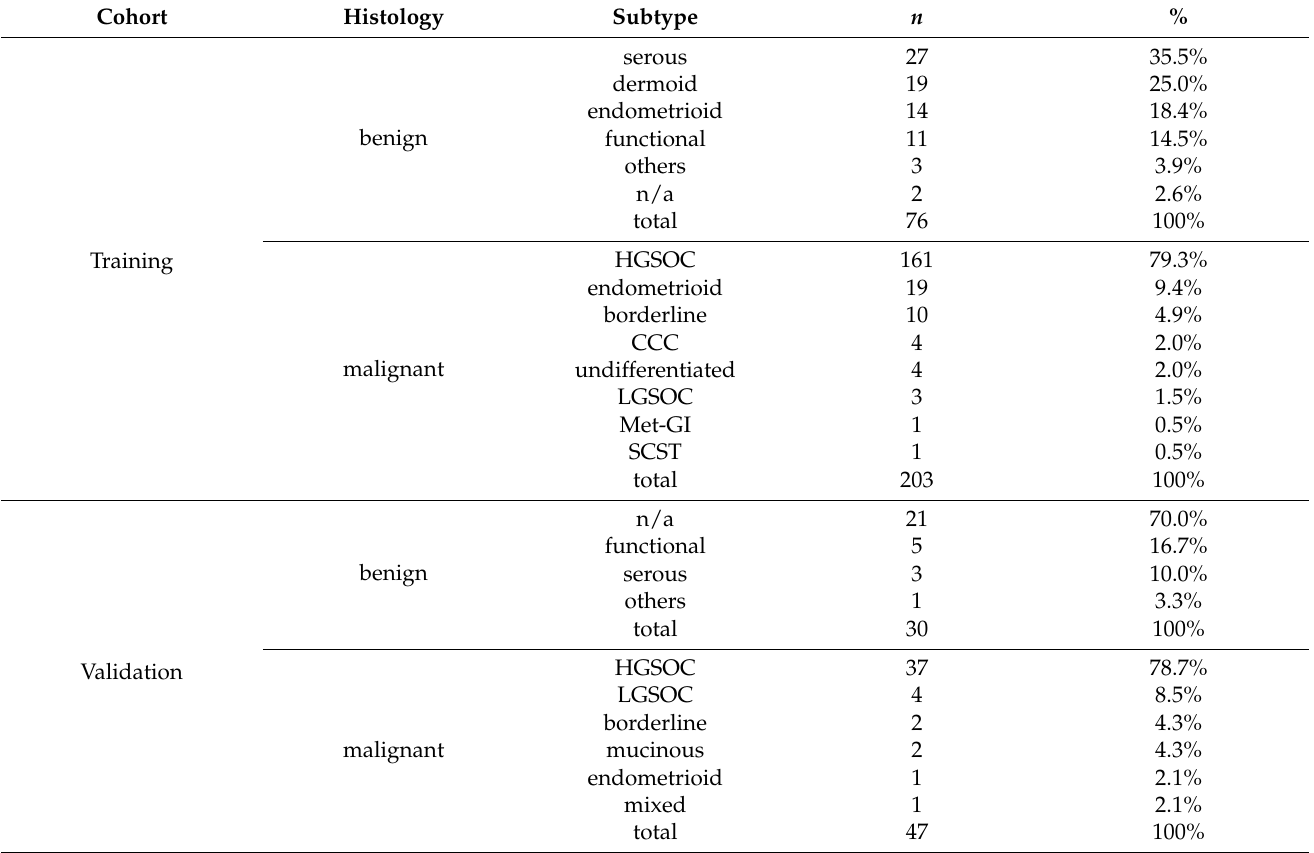
Table A1. Distribution of histological